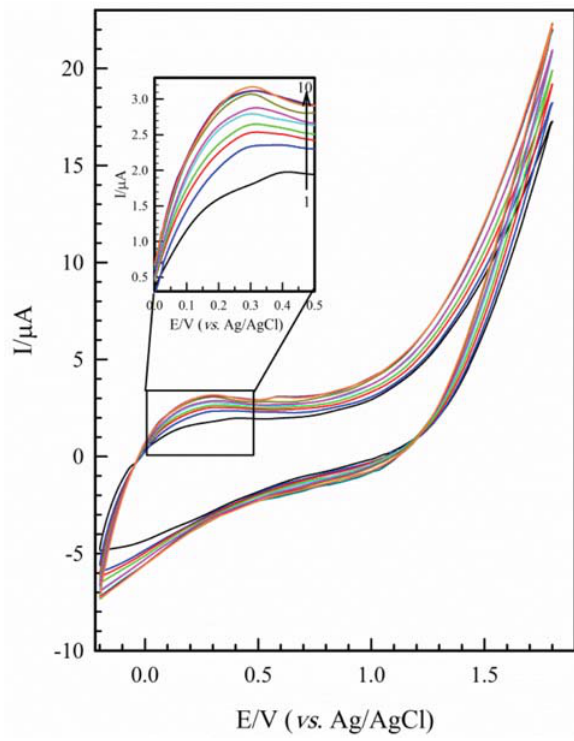
Figure 1. Successive cyclic voltammograms of GCE in 0.11 M PBS (pH 3) containing the suspension of DB/MWCNTs for first 10 cycles. The scan rate was 0.100 V s –1